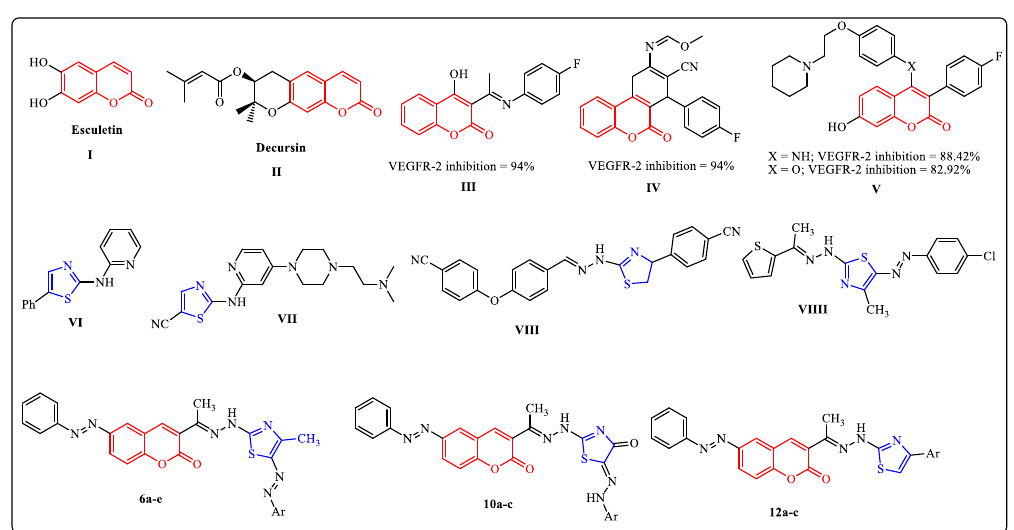
Figure 2. Examples of some reported coumarins (I – V) and thiazoles (VI – VIIII) based VEGFR-2 inhibitors and the target compounds 6a – e , 10a – c and 12a – c .